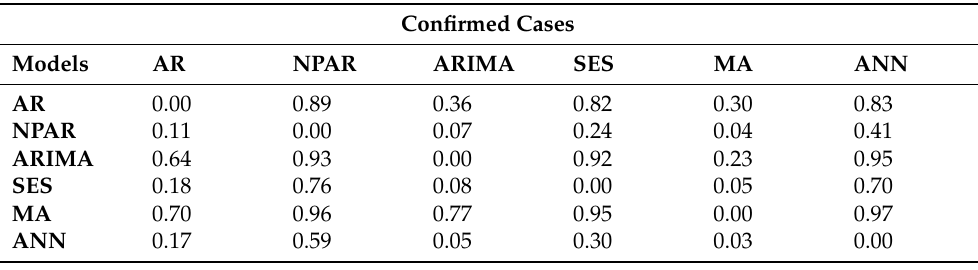
Table 5. Results ( p -value) of the DM test for all the considered models using the confirmed cases. Confirmed Cases